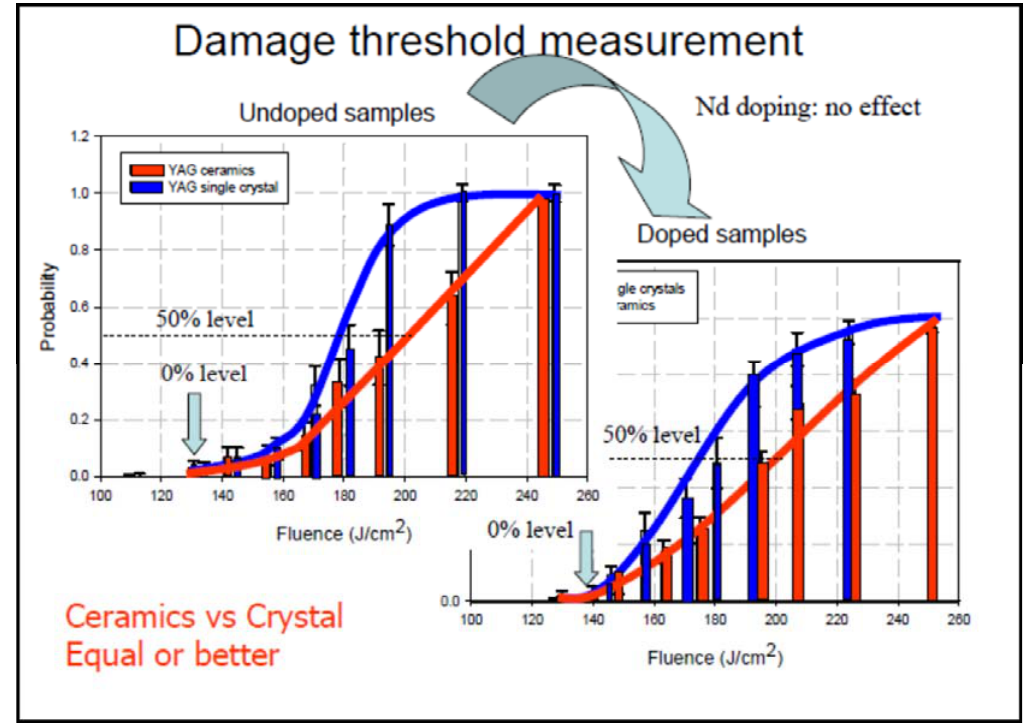
Figure 6. Laser damage threshold for rare earth doped and undoped YAG ceramics compared with single crystal YAG (Adapted from Ueda et al.